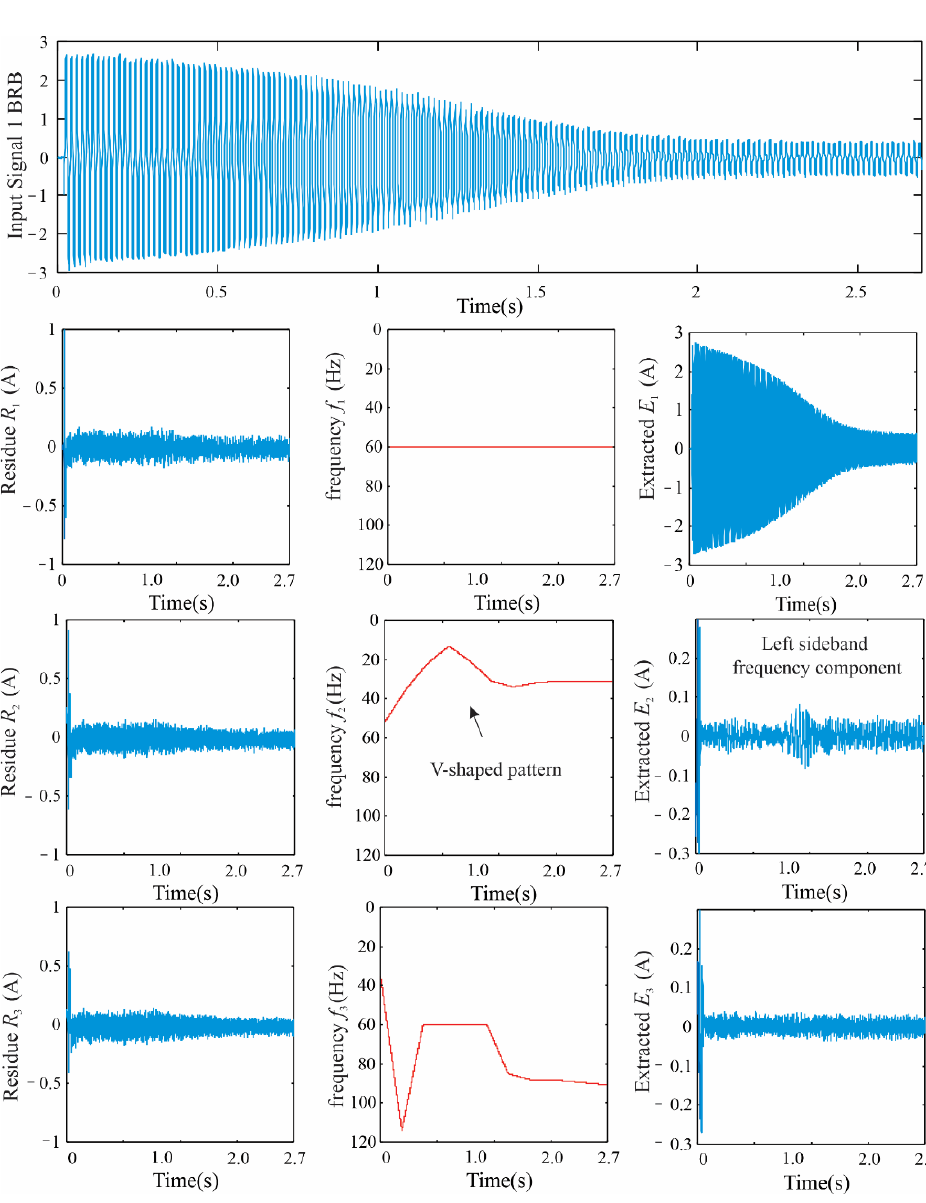
Figure 12. FBASD output for the 1BRB case.